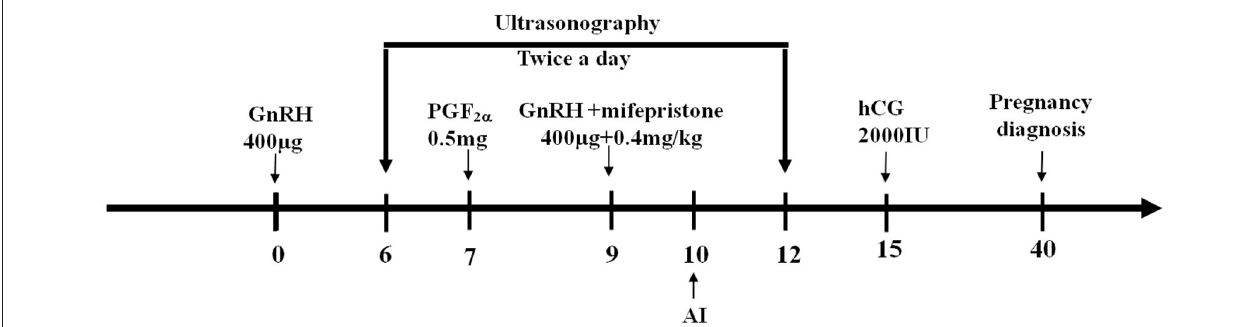
FIGURE 2 | Schematic diagram of GPGMH method. Crossbred buffaloes have received an intramuscular injection of 400 µ g GnRH on day 0, followed by an injection of 0.5mg PGF2 α on day 7, the second injection of 400 µ g GnRH and one injection of 0.4 mg/kg mifepristone on day 9, artificial insemination on day 10, an injection of 2,000 IU hCG on day 15, and a pregnancy diagnoses on day 40 of protocol.